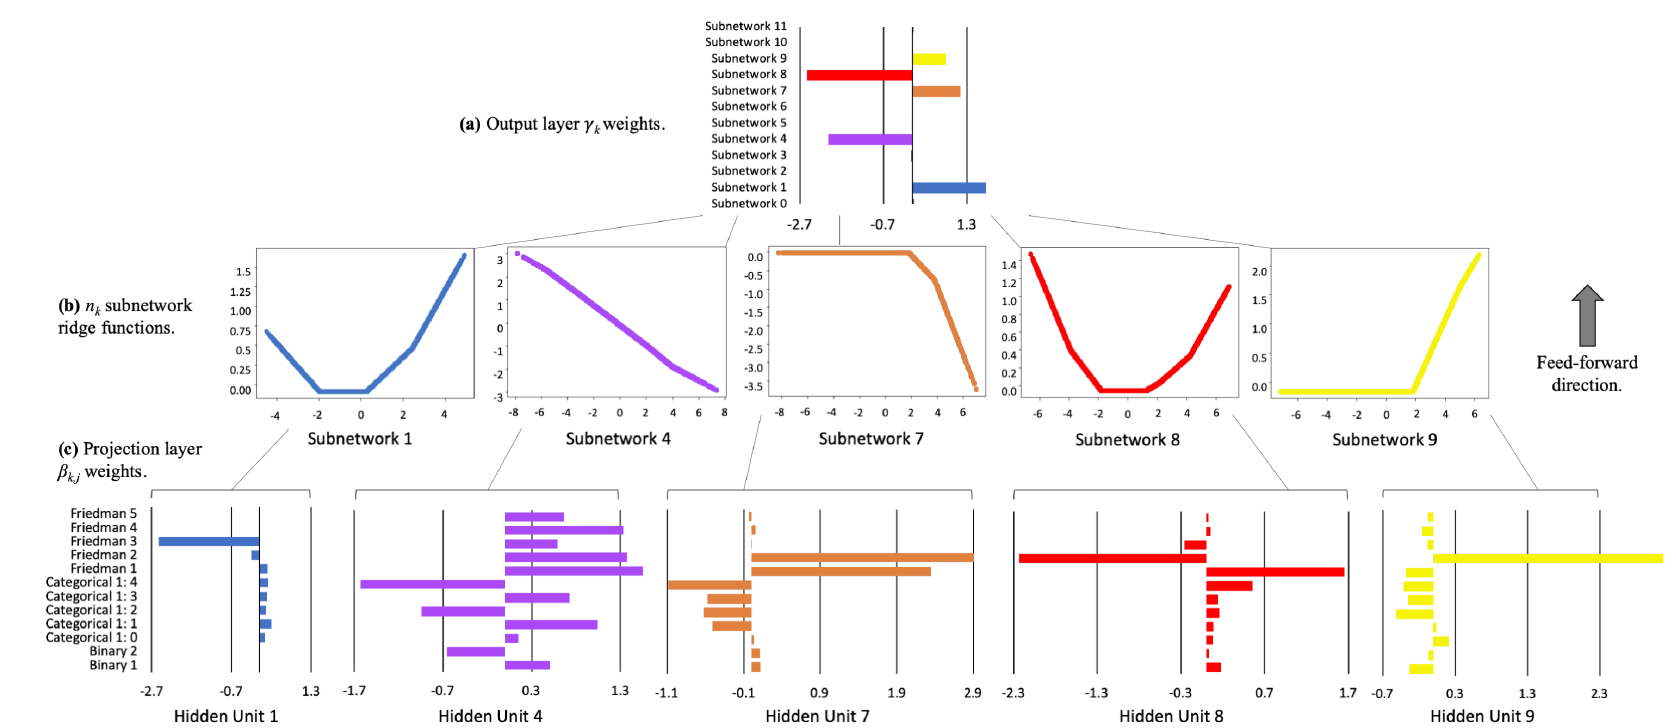
Figure 1. Output layer γ k weights, corresponding n k subnetwork ridge functions, and associated projection layer β k , j weights for g XNN on the simulated